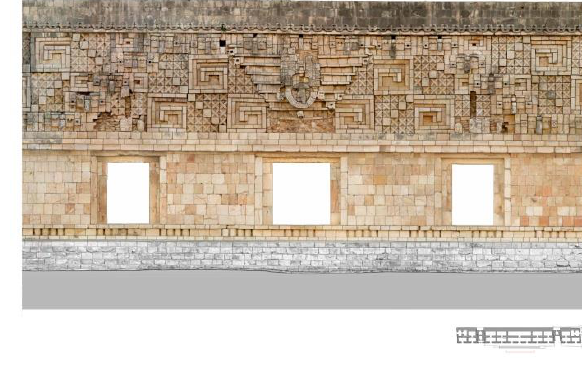
Figure 18. Photogrammetric view of the Palace of the Governor’s front facade central elevation. (Project MAYATECH